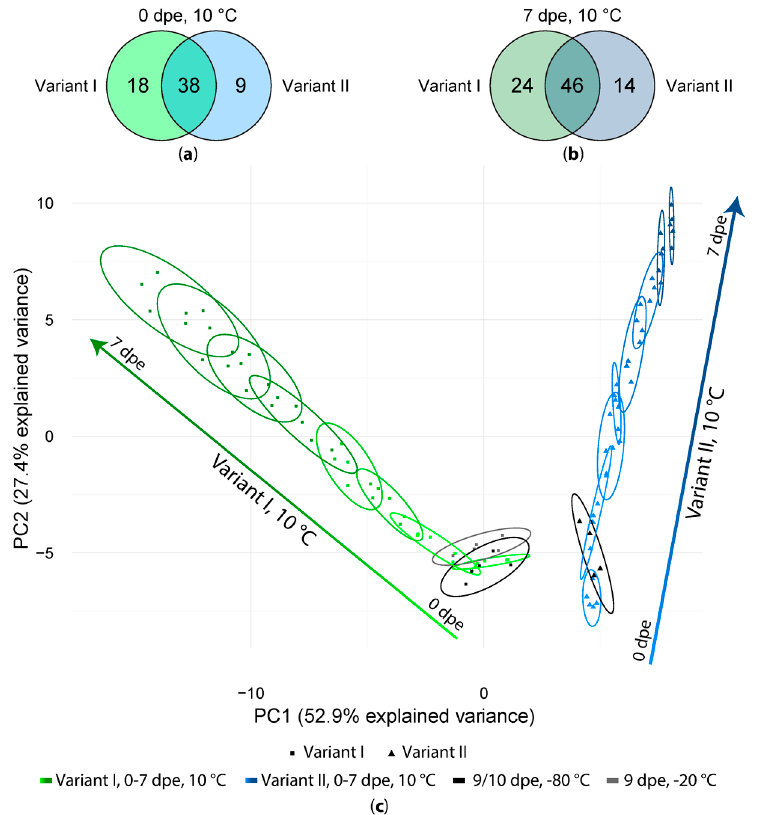
Figure 3. ( a ) Number of artifact compounds detected in freshly extracted samples (0 dpe) in variant I and variant II; ( b ) Same comparison as in ( a ) but for the samples measured after one week (7 dpe); ( c ) PCA score plot of all variant I and II samples.